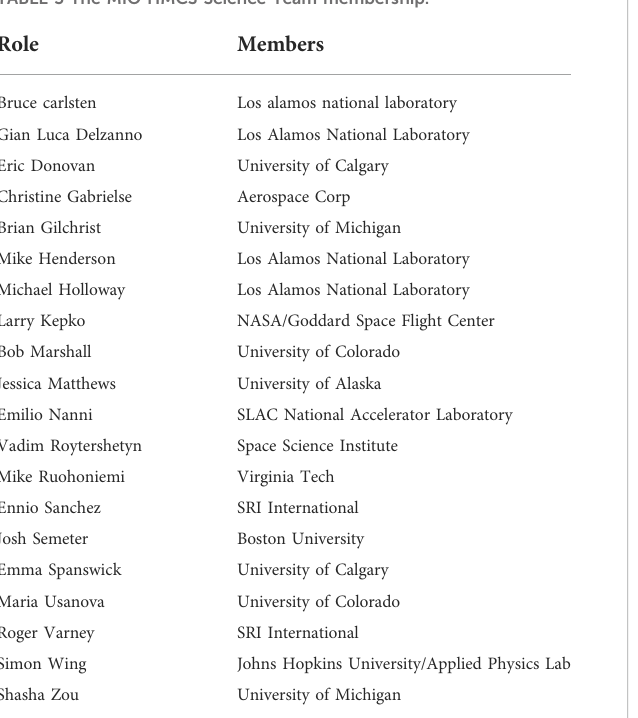
TABLE 3 The MIO HMCS Science Team membership.